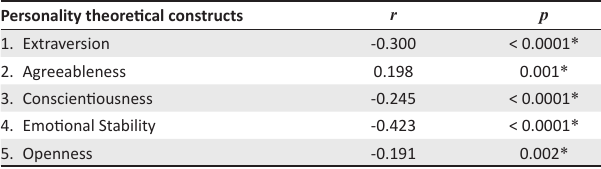
TABLE 2: Pearson product-moment correlations ( r ) and significance probabilities ( p ) for relations of time-based conflict to personality theoretical constructs. Personality theoretical constructs